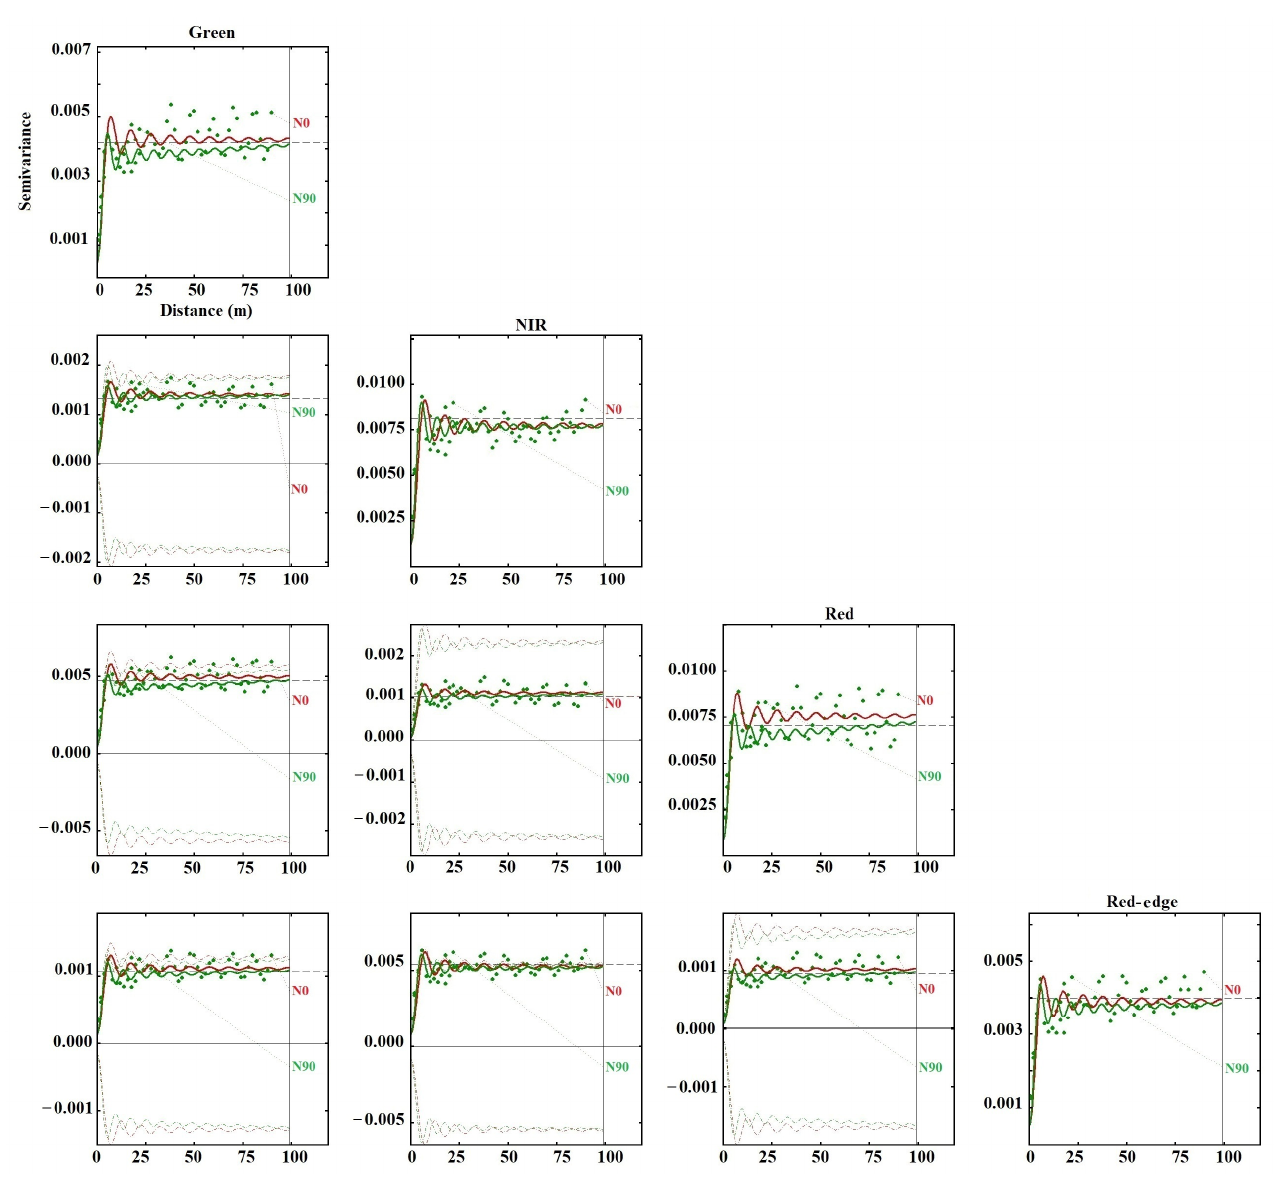
Figure 4. Directional LMC fitted to multi-band data: red line = variogram model along 0 degrees direction from North (N0); Green line = variogram model along 90 degrees direction from North (N90). Dots correspond to the experimental variogram. Dashed line corresponds to intrinsic corre- lation.